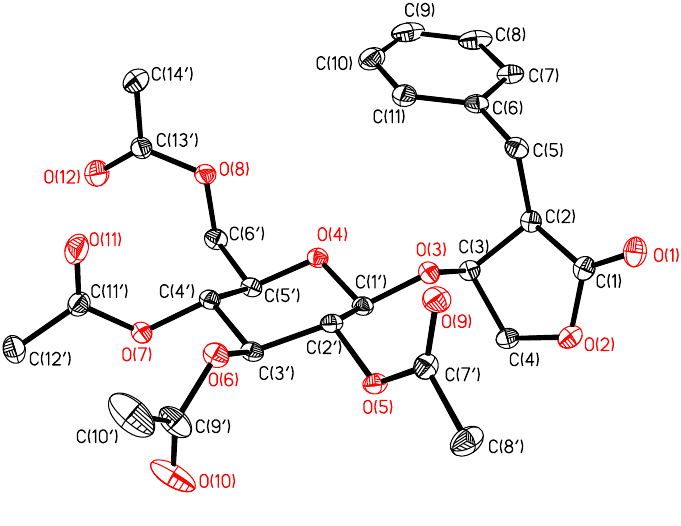
Figure 3. Perspective view of the crystal structure of compound 5d